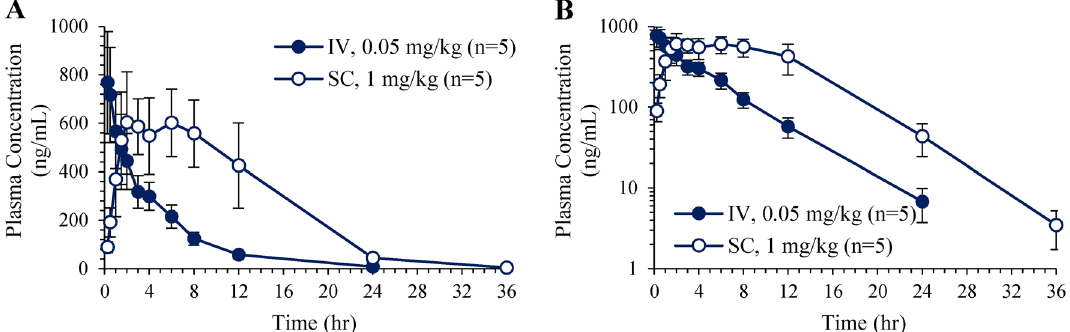
Fig. 3 Plasma concentration–time profiles of liraglutide following intravenous (IV, 0.05 mg/kg) and subcutaneous (SC, 1 mg/kg) injection in rats A on a linear plot and B on a semi-log plot (mean